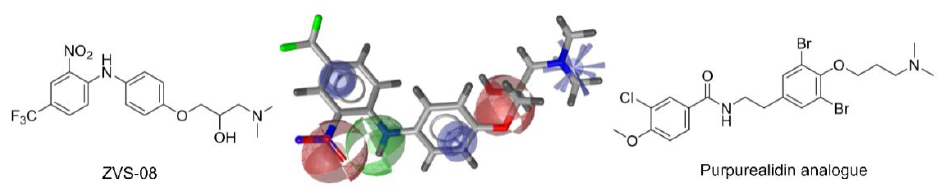
Figure 8. Alignment of the identified potent K V 10.1 hit compound ZVS-08 with the final ligand-based pharmacophore model used for virtual screening (middle), structures of the most active purpurealidin analogue (right) and virtual screening hit compound ZVS-08 (left).